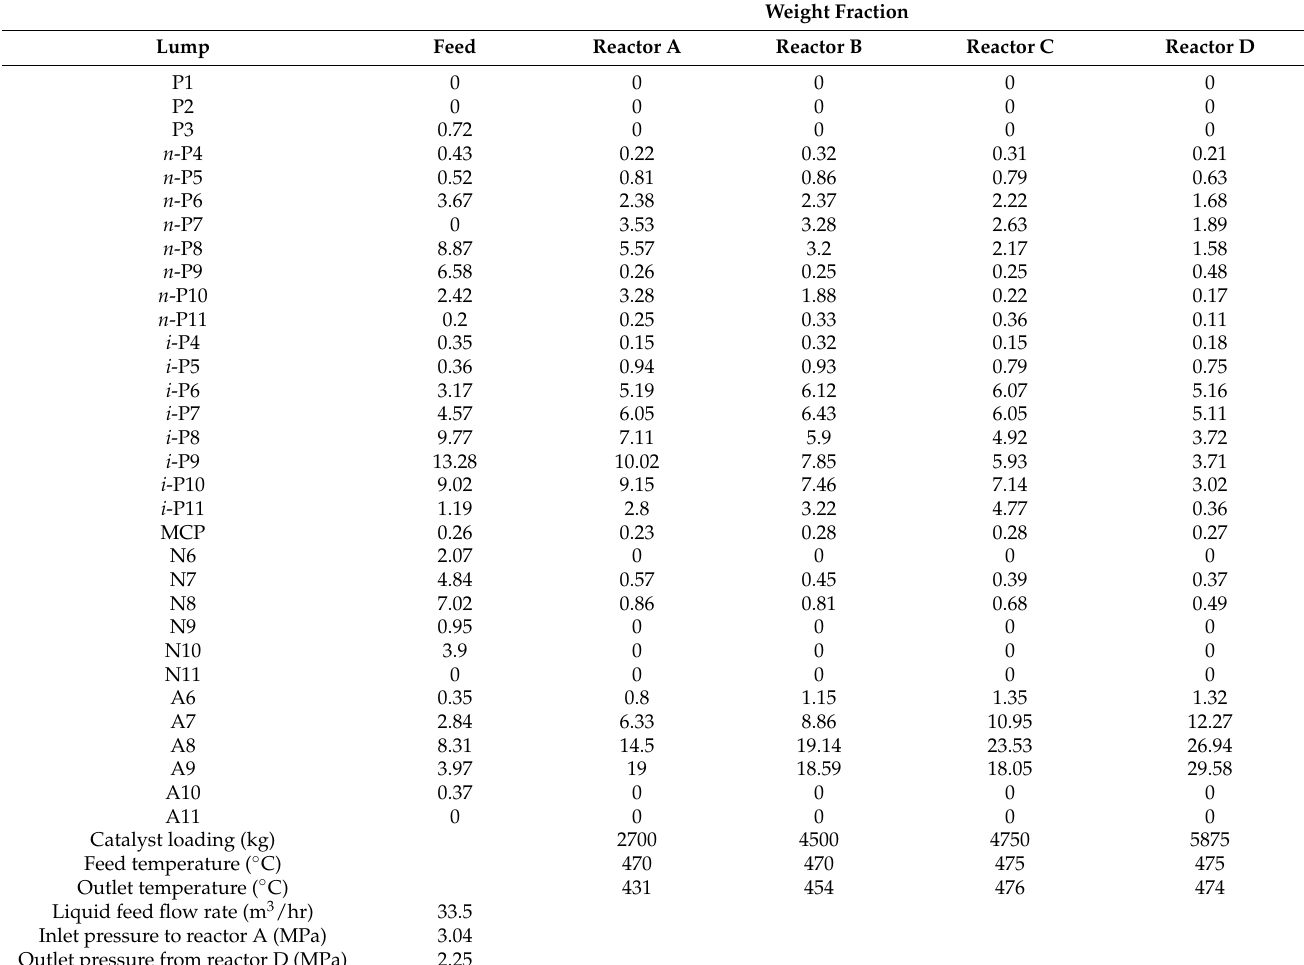
Table 1. Dataset of the weight fractions of the streams, catalyst loading, and operating conditions.